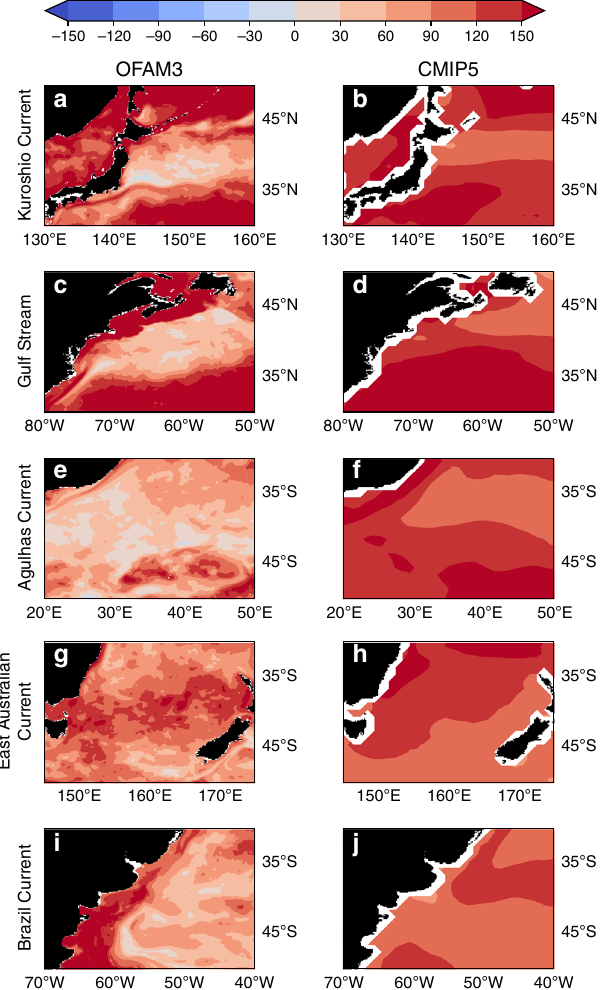
Fig. 5 Projected marine heatwave days in western boundary current regions. Spatial comparisons of projected changes (2021 – 2050 minus 1982 – 2018) in annual marine heatwave (MHW) days in a , b Kuroshio Current, c , d Gulf Stream, e , f Agulhas Current, g , h East Australian Current and i , j Brazil Current regions between the high-resolution (0.1°) ocean model output (OFAM3; left column) and the 1° multi-model mean product of 23 global climate models (CMIP5; right column) under the Representative Concentration Pathway